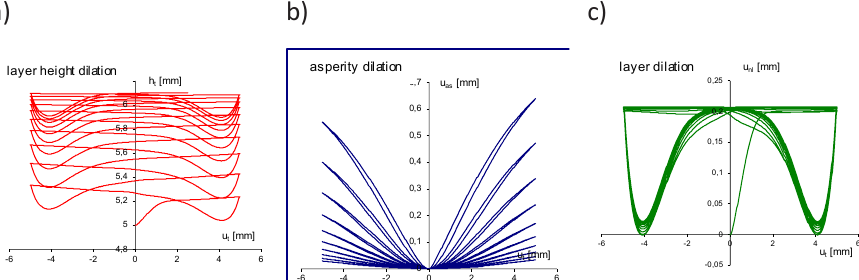
= 10 MPa : a) variations of contact layer height, b) asperity n